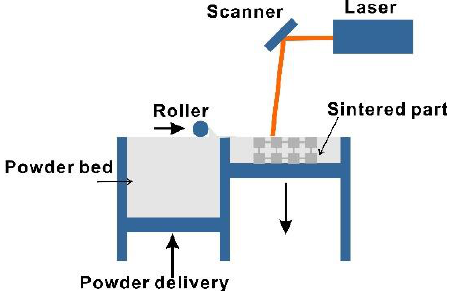
Figure 4. Schematic illustration of the selective laser sintering system.